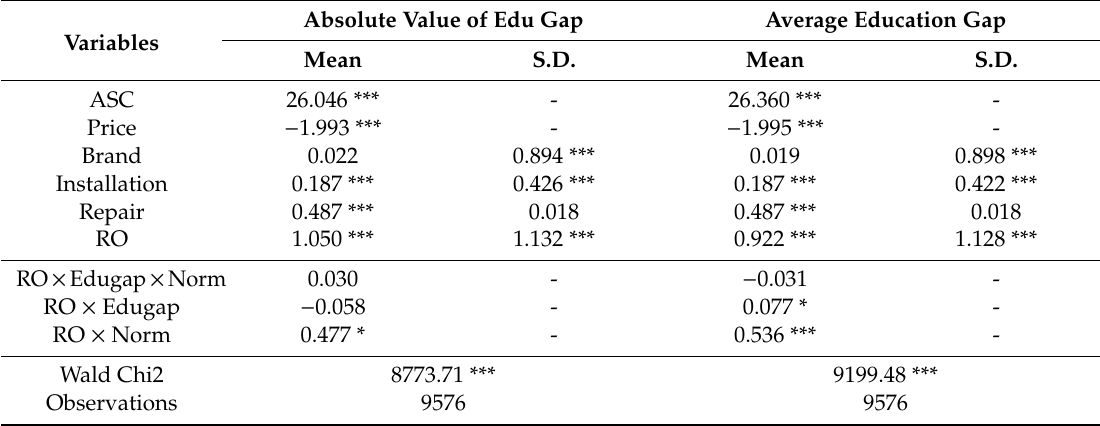
Table 9. The results of mechanisms on the average education